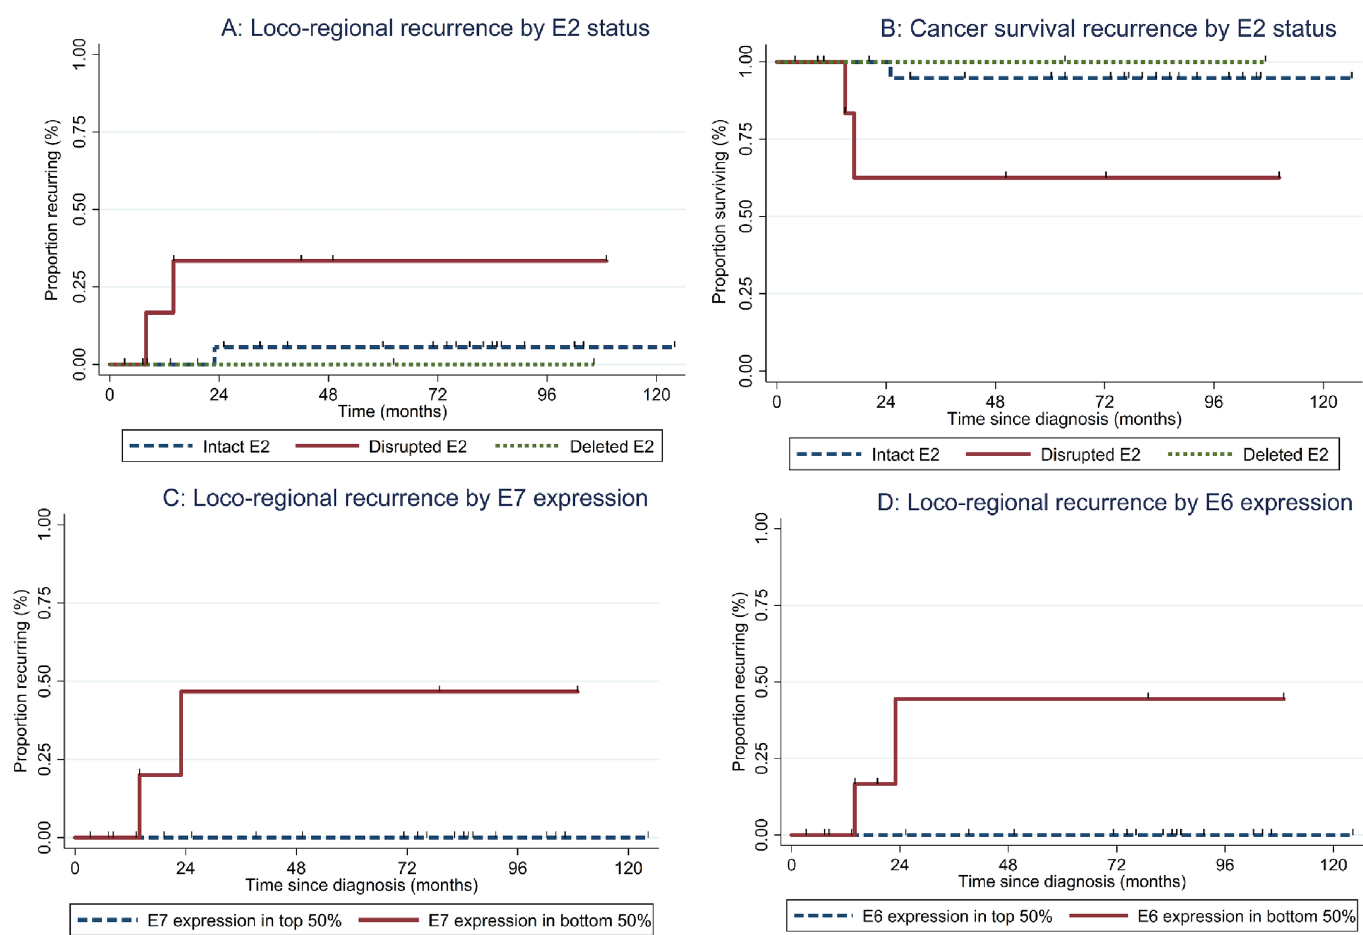
Fig 5. Association of local-regional recurrence and disease specific survival with HPV16 E2 disruption in the oropharynx. (A) Samples with an intact E2 gene (broken black line) have a lower incidence of local regional recurrence than oropharyngeal cases with a disrupted E2 gene (solid black line) (Mantel-Cox test p = 0.04). (B) Samples with an intact E2 gene (broken black line) have better disease specific survival than oropharyngeal cases with a disrupted E2 gene (solid black line) (Mantel-Cox test p = 0.03). (C and D) Samples were separated into high (broken black) or low (solid black) expression of viral genes based on median cutoff using derived (2max Δ CT- Δ CT) qRT-PCR results compared to GAPDH for: (C) HPV16 E7 (median = 1.69 2max Δ CT- Δ CT; Mantel-Cox test p = 0.004), and (D) HPV16 E6 (median = 1.23 2max Δ CT- Δ CT; Mantel-Cox test p = 0.006).